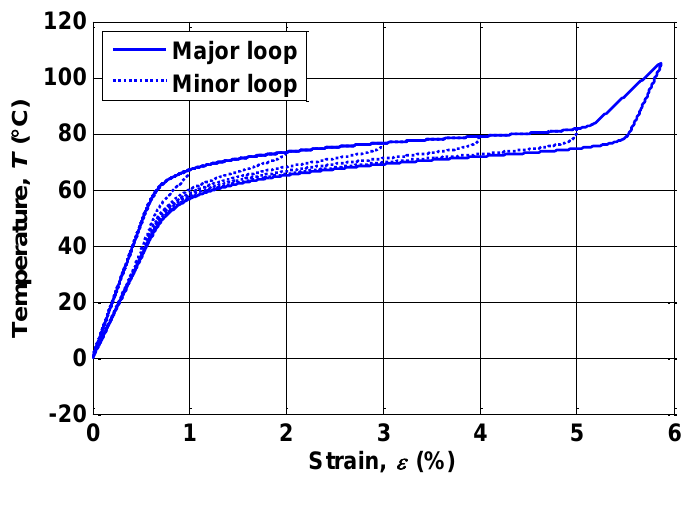
Figure 9. Simulated inverse hysteresis characteristics of SMA